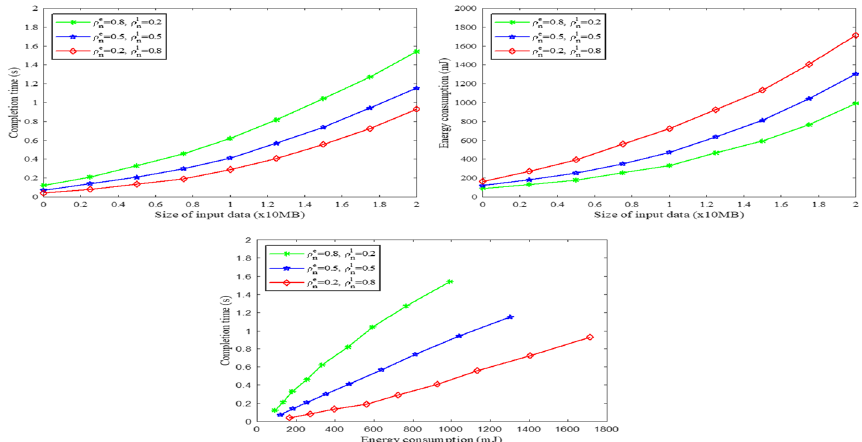
Fig. 7 Performance of HHFSHS algorithm with relative percentage tasks